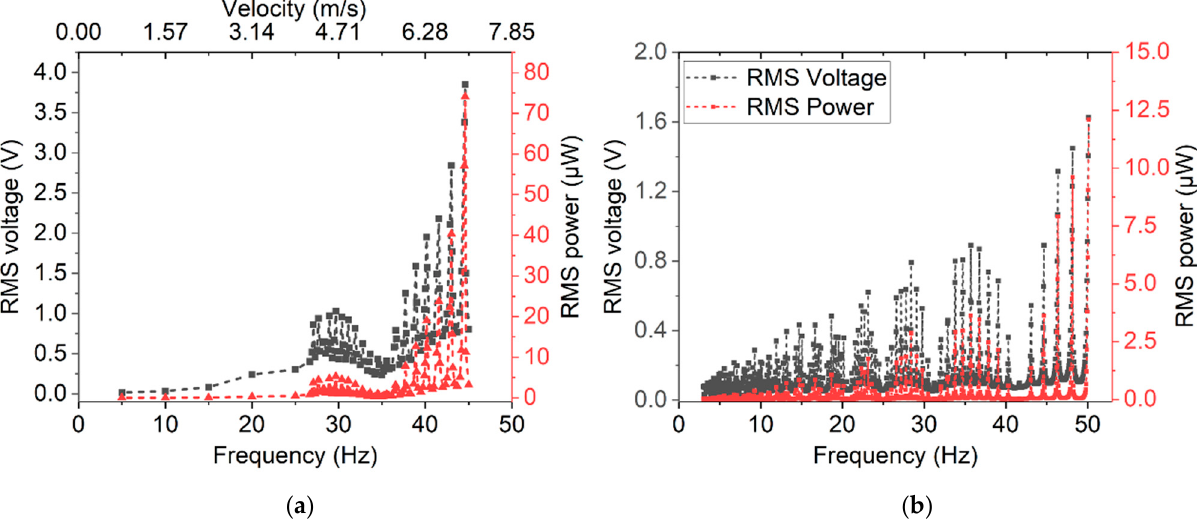
Figure 21. RMS voltage and calculated RMS power output achieved for design 2 harvesters at different excitation rates: ( a ) magnetic excitation with rotating pole wheel; ( b ) mechanical excitation at a constant acceleration of 51 g.